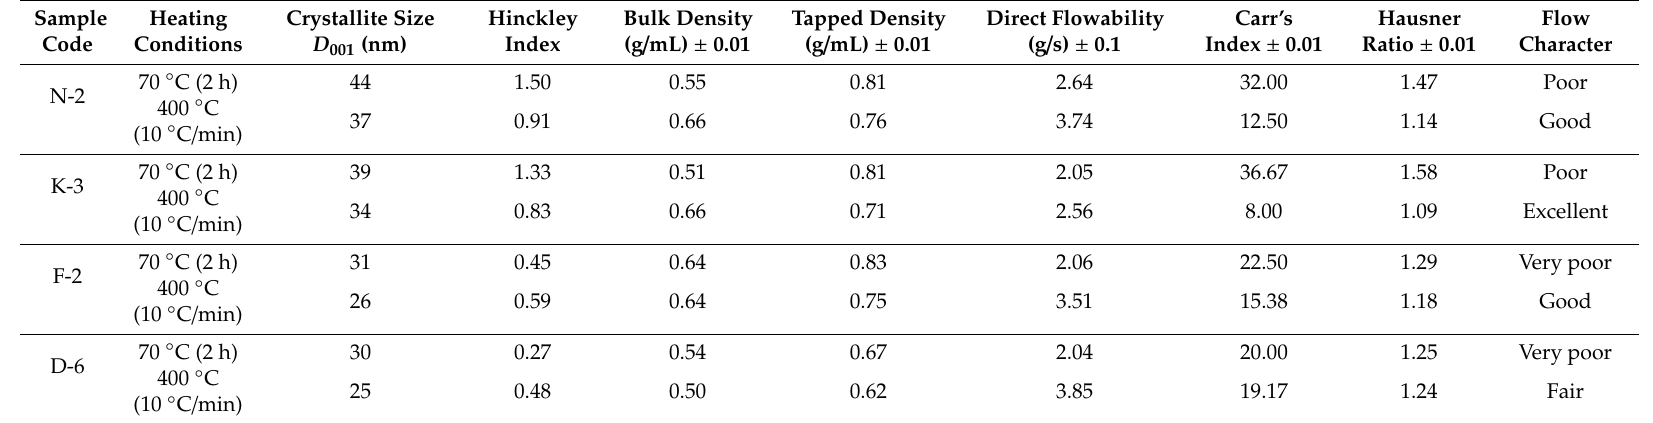
Table 2. Kaolinite structural characteristics (crystallite size and order-disorder degree), bulk and tapped density values and flowability parameters of the studied dried (at 70 ◦ C) and dehydrated (at 400 ◦ C) kaolin